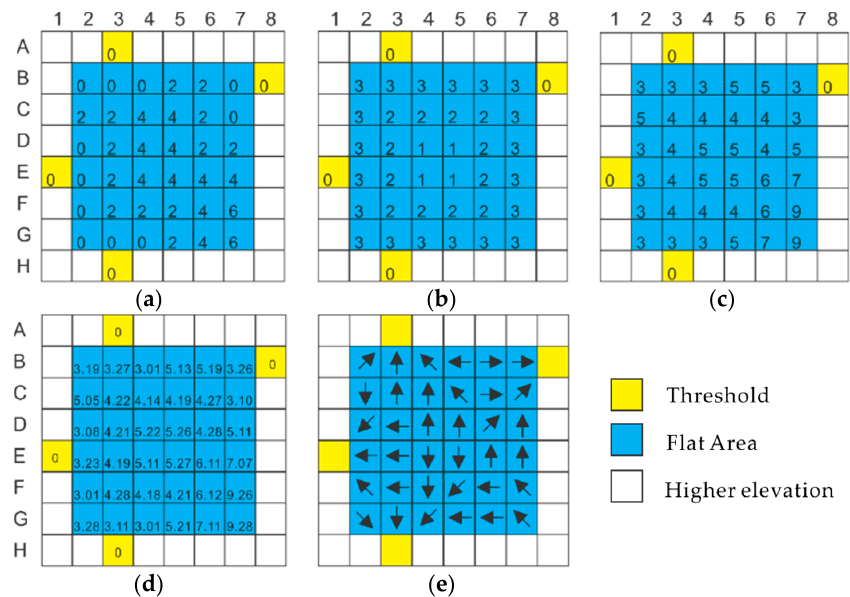
Figure 3. Procedures for flat areas with multiple thresholds: ( a ) increment numbers in step 1; ( b ) increment numbers in step 2; ( c ) combined increment numbers from steps 1 and 2; ( d ) final increment numbers after adding random increments; and ( e ) final flow directions of the corrected